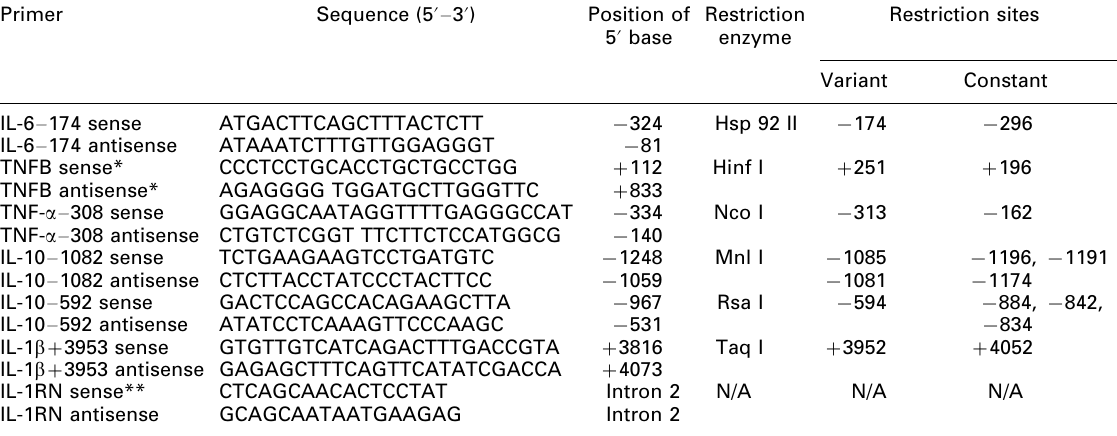
Table 2. PCR primer sequences with the position of the 5 ? base, restriction enzymes, and cut sites